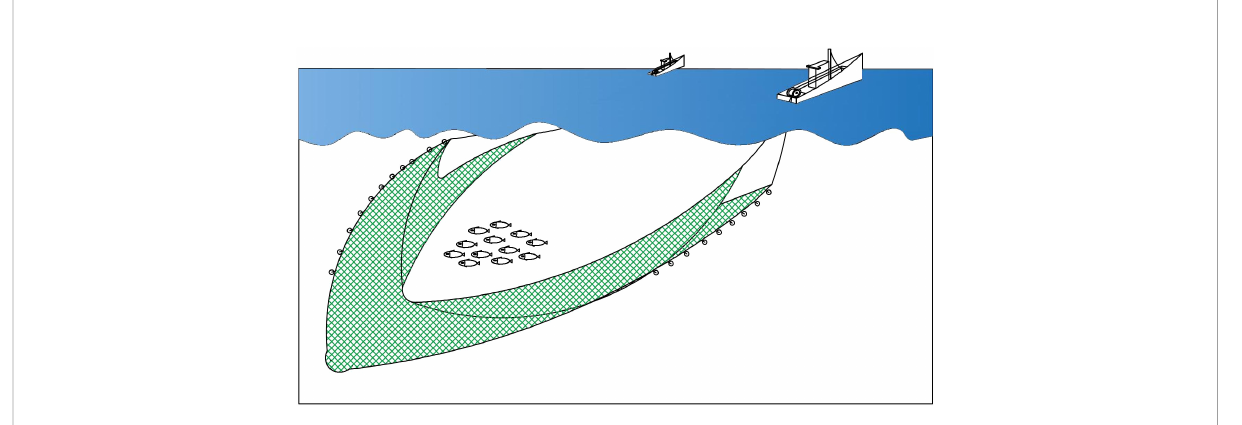
FIGURE 2 Schematic diagram of double-vessel purse seine